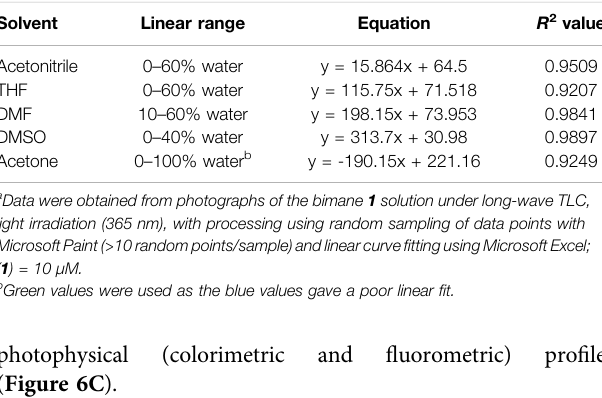
Frontiers in Chemistry |